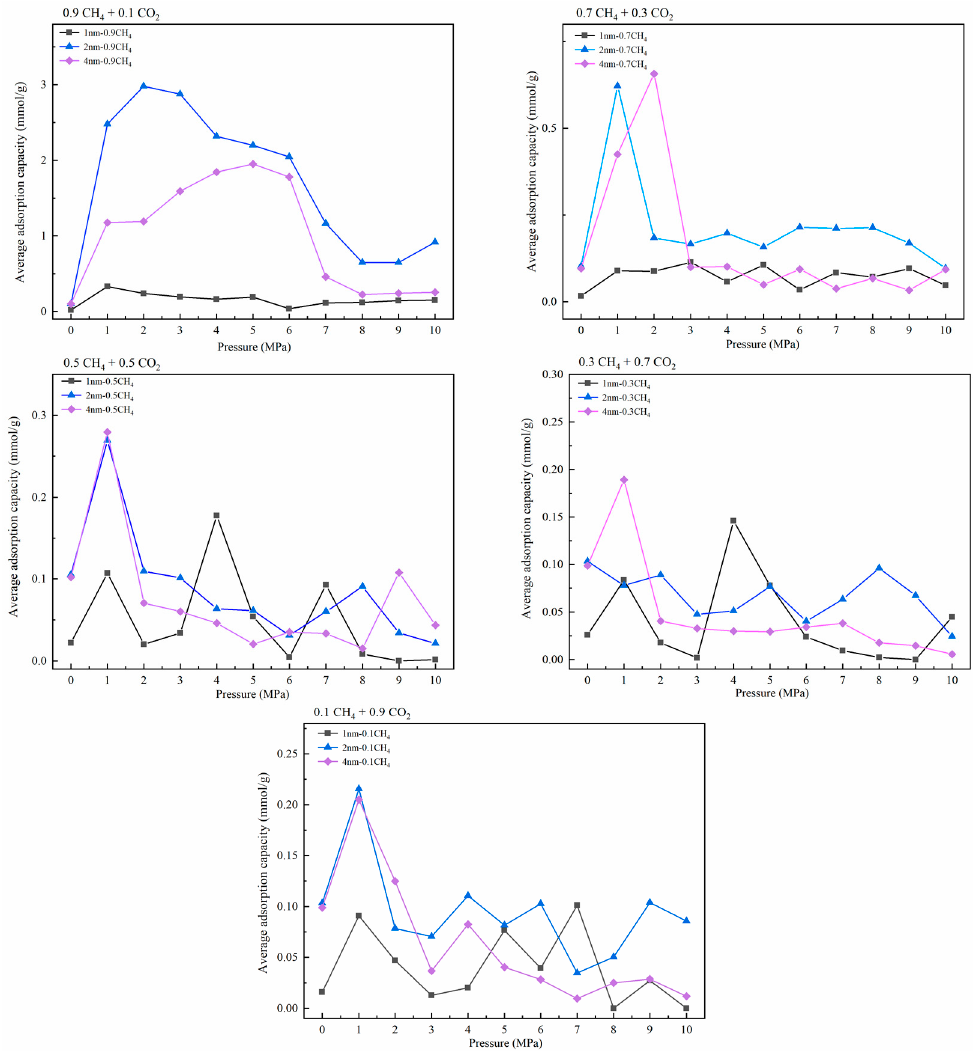
Figure 6. Adsorption isotherms of different ratios of CH 4 at 293.15 K.